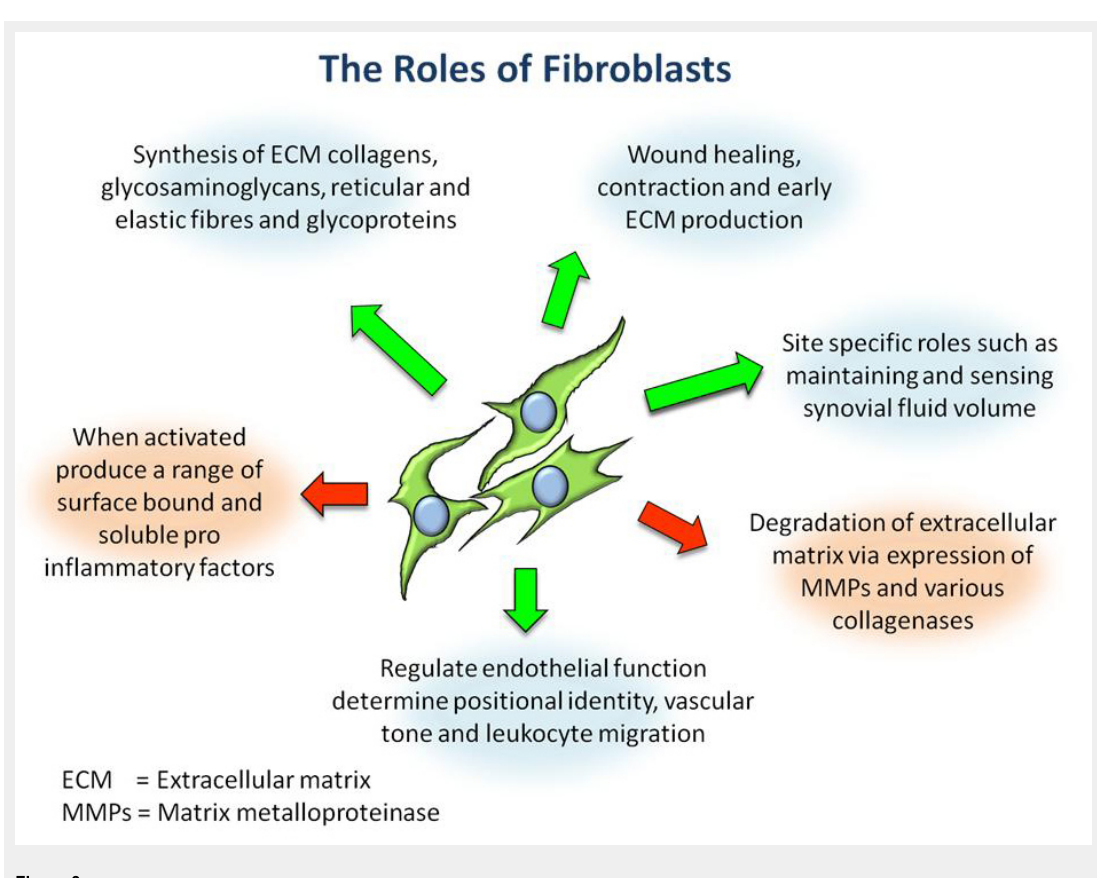
Figure 3 Overview of the diverse roles of stromal fibroblasts within connective